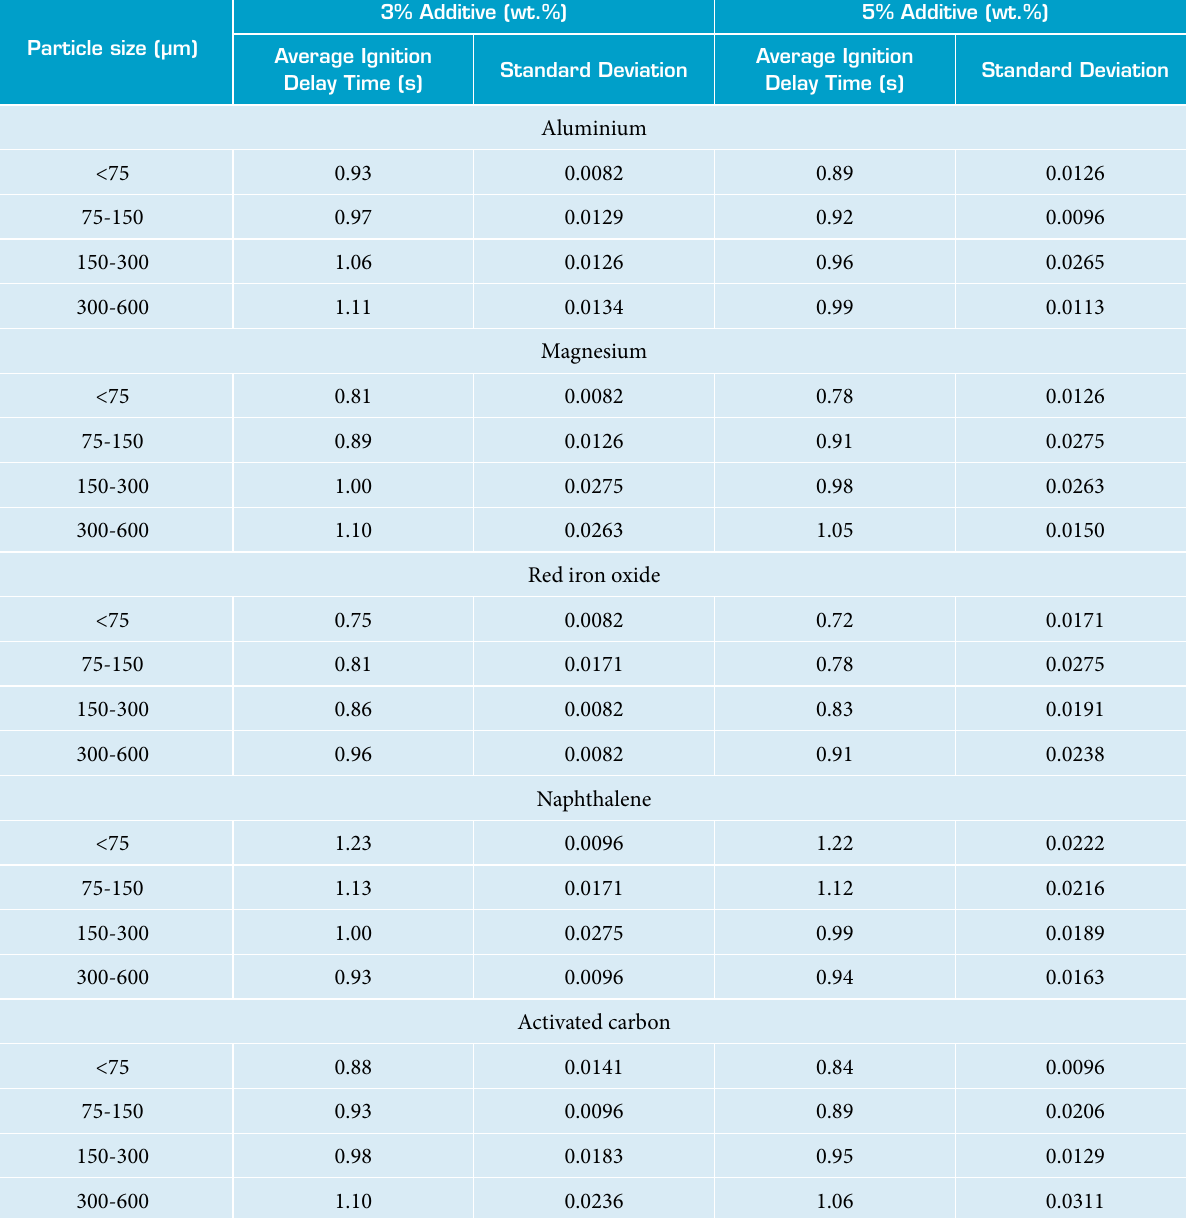
Table 3. Average ignition delay time in pyrotechnic